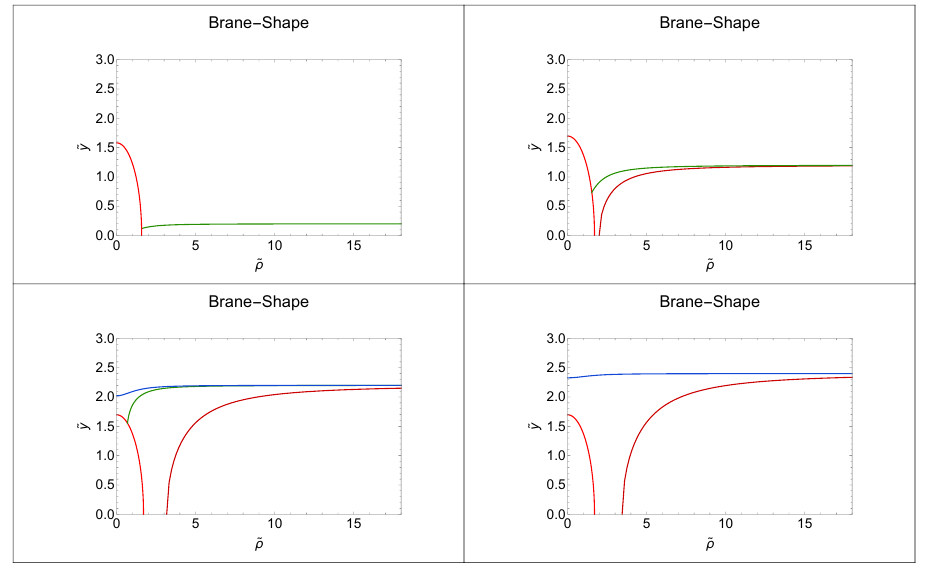
Figure 4 . D7-brane in BH geometry for r 0 > r m